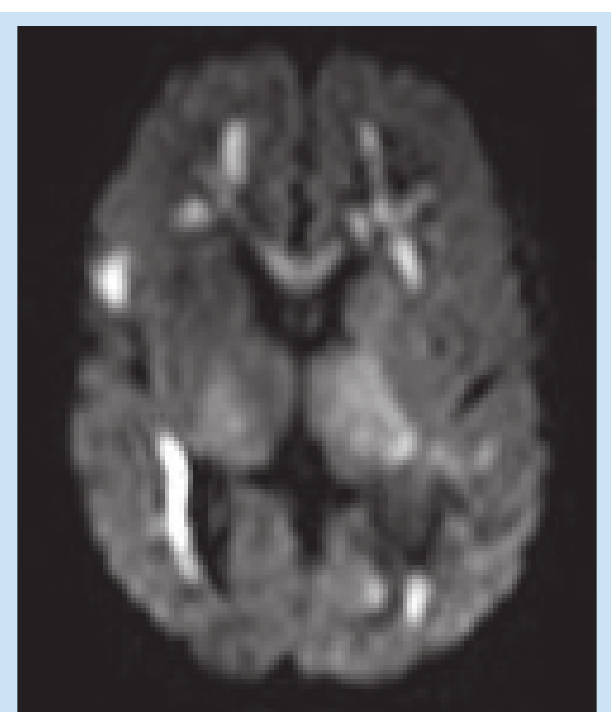
Fig. 3. DWI (B 1000). There is high signal in the periventricular white matter and thalami consistent with hypoxic injury. The haematoma and intraven- tricular blood on the left is hypointense: ‘blackout’